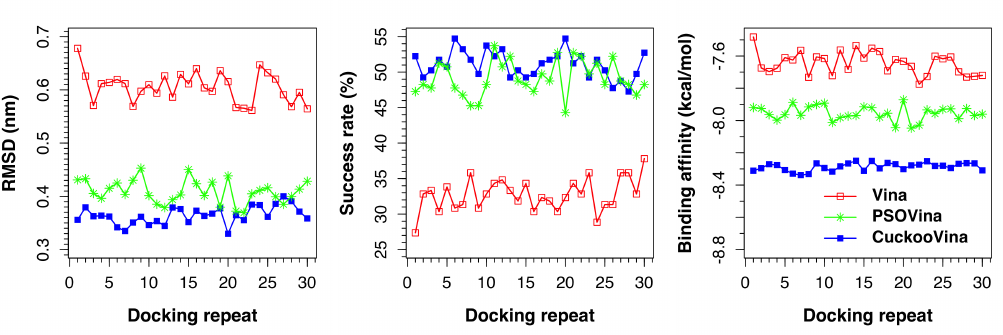
Figure 1. Docking performances of AutoDock Vina, PSOVina, and CuckooVina in 30 independent docking repeats using the PDBbind 2012 dataset. Each data point is an average of 201 complexes.